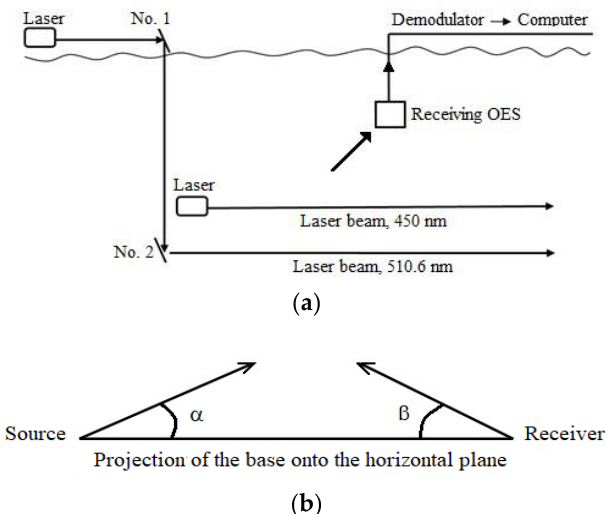
Figure 9. Geometric schemes of experiments: ( a ) side view: the green laser is placed on the bank of the lake, and the dark blue laser is immersed in water; ( b ) top view: directions of the optical axes of the source and receiving systems.